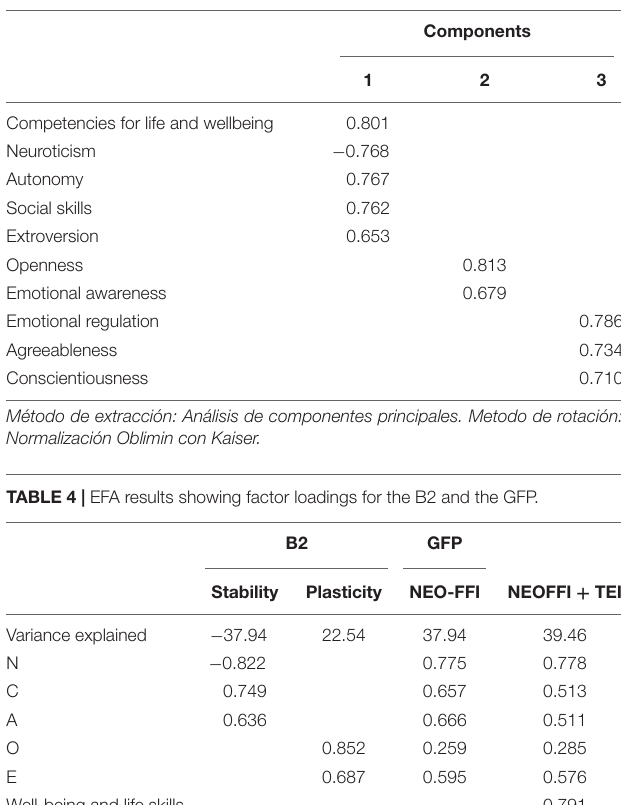
TABLE 3 | Combined factor analysis of trait EI and B5 dimensions.